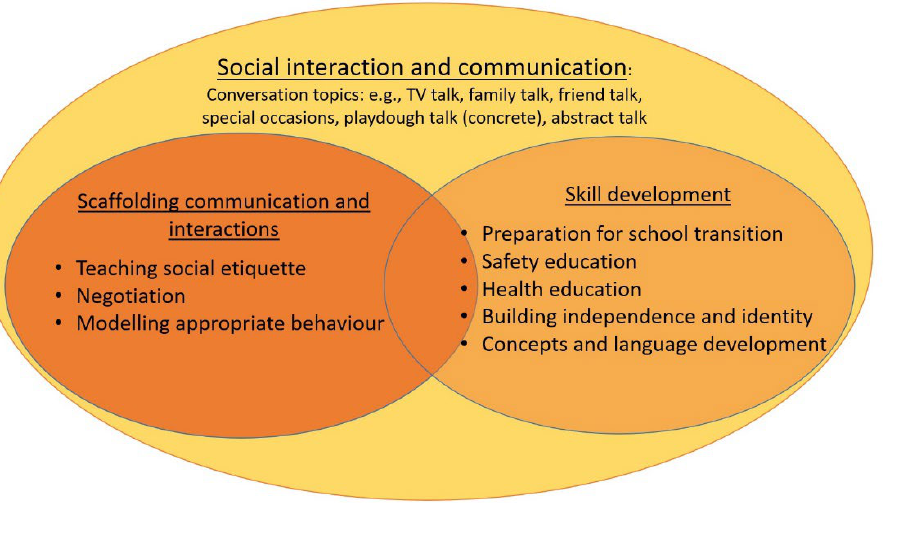
Figure 1: Themes in the interactions between educators and children